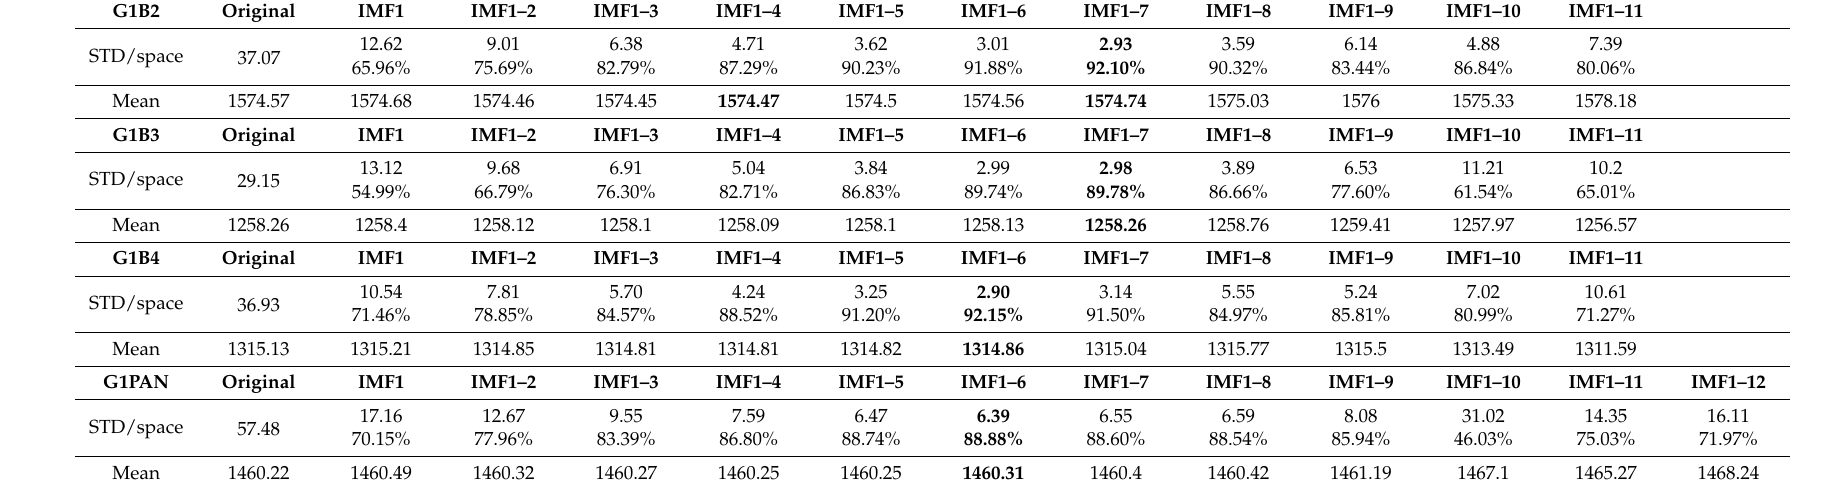
Table 3. Same as Table 2, but for flying mode test imagery of gain setting G1. G1B2 stands for G1 Gain and Band 2,